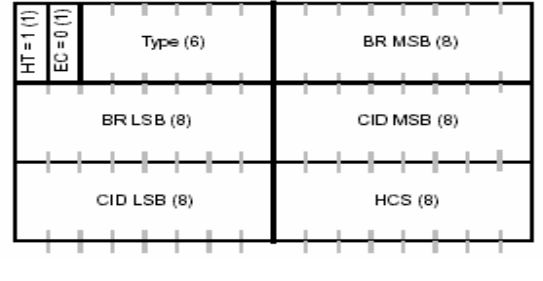
Figure 4. Bandwidth Request Header Format